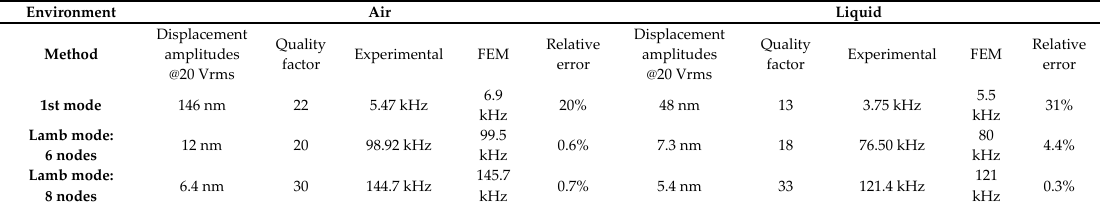
Table 1. Displacement amplitudes, quality factors and comparison of the resonant